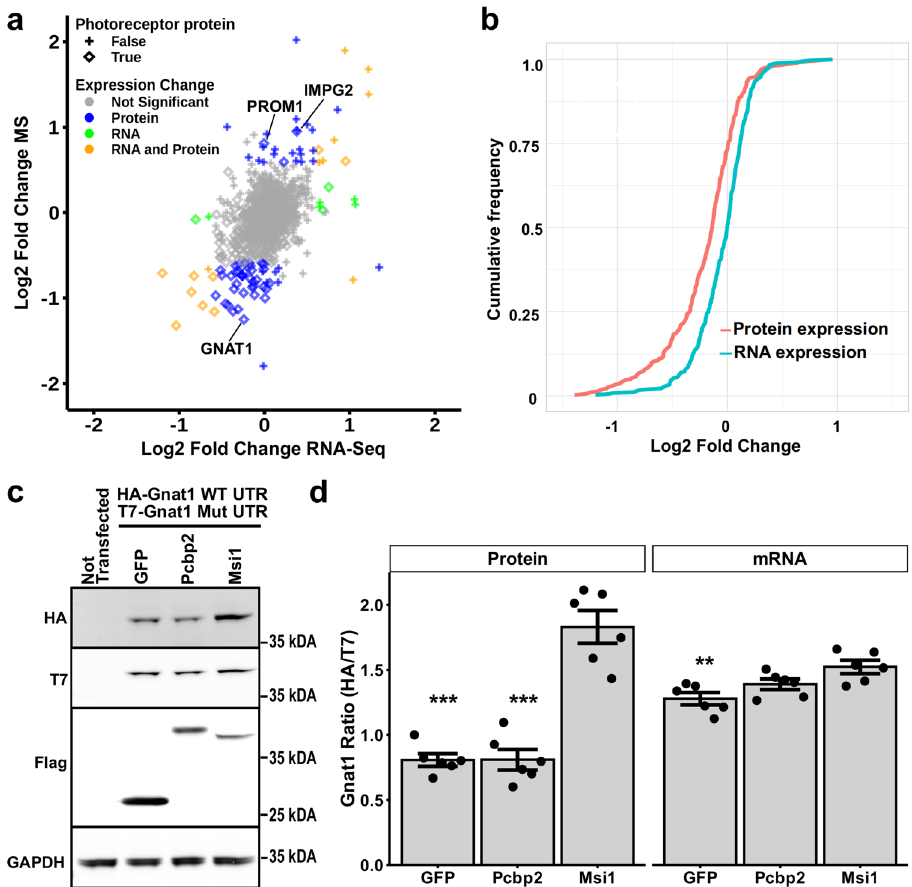
Fig. 8 In photoreceptor cells MSI1 and MSI2 act to promote protein expression post-transcriptionally. a Scatter plot comparing protein and transcript levels changes after double Msi1 / Msi2 knockout in mature photoreceptor cells. Protein expression was quanti fi ed by isobaric labeling and mass spectrometry. Transcript expression levels were determined by RNA-Seq. Genes that are highly expressed speci fi cally in photoreceptor cells are shown as rombs and genes highly expressed outside of photoreceptor cells are shown as crosses. Color indicates signi fi cant changes in protein levels alone (blue), in mRNA levels alone (green), in both protein and mRNA levels (orange), or no signi fi cant change in expression (gray). b Cumulative frequency plots showing the deletion of Msi1/Msi2 in mature photoreceptors leads to broad decrease of photoreceptor protein levels in excess to changes in transcript levels (Kolmogorov – Smirnov p -value = 1.1*10 − 12 ). c Western blot analysis of recombinant GNAT1 expression in NIH 3T3 cells. Cells were transfected with equal amounts HA-tagged Gnat1 clone with wild type 3'-UTR and T7-tagged Gnat1 clone with mutant 3'-UTR that lacks Musashi binding sites. Each transfection included one of the following: vector expressing fl ag-tagged GFP, vector expressing fl ag-tagged Pcbp2 , and vector expressing fl ag-tagged Msi1 . Non transfected cells were included as a control for the speci fi city of the antibodies. TUBB serves as loading control. Size markers indicate the molecular weight in kDA. d Ratios of the HA (wild type) to T7 (mutant) tagged GNAT1 proteins and ratios of the corresponding RNA transcripts in the transfected NIH 3T3 cells. The data is represented as mean ± SEM of six replicates. The statistical signi fi cance of the effect of MSI1 in pairwise comparisons to the controls was determined by Tukey HSD. Signi fi cance level is indicated as: * p -value < 0.05, ** p -value < 0.01, *** p -value < 0.001. Supplementary Data 15 contains the source data underlying the graph on d . Uncropped blots used underlying the data shown on c , d are shown on Supplementary Fig.